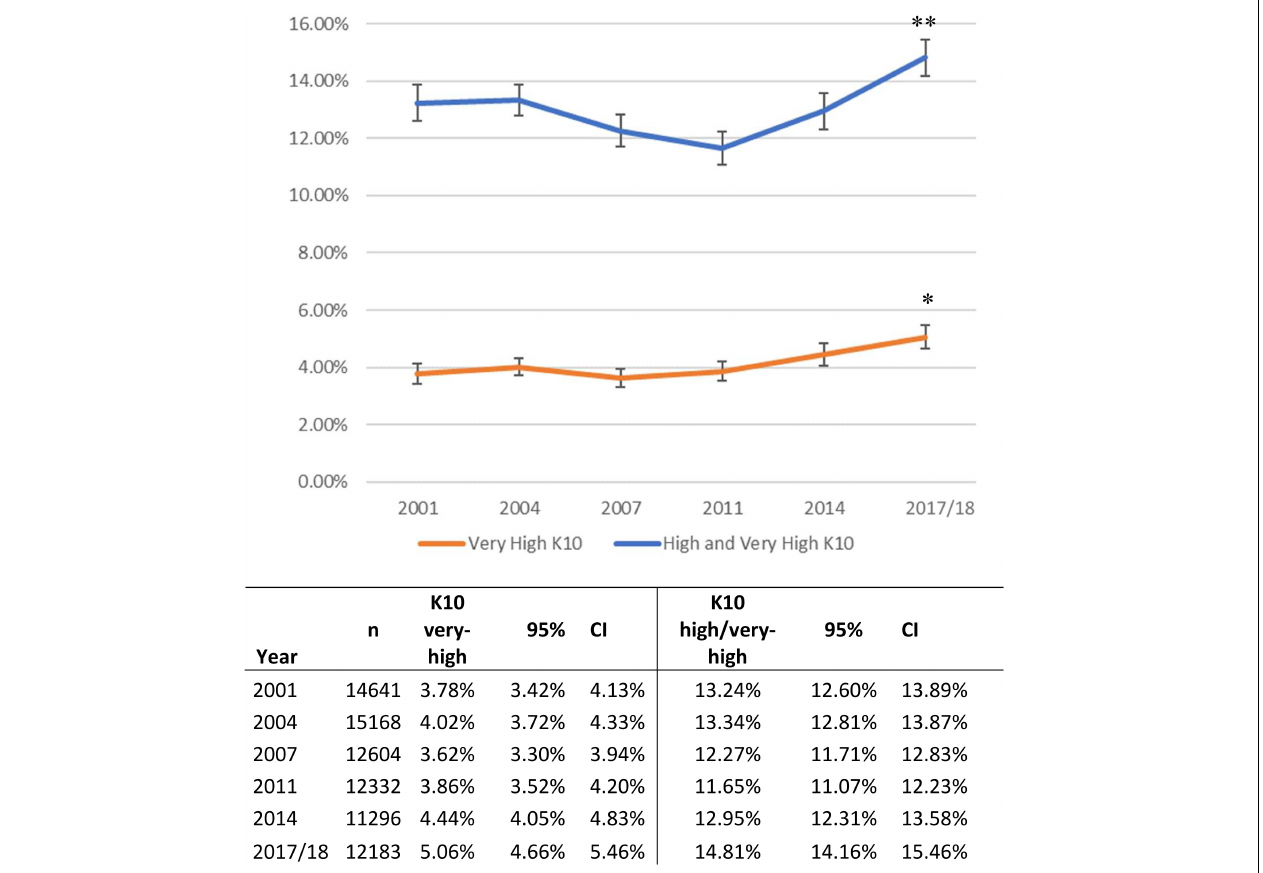
FIGURE 1 | Age-standardized prevalence of psychological distress in the Australian working age population, 2001–2017. a Standardized to 2001 Australian Census. Derived from a total of n = 78,204 survey participants aged 18–64 years. ∗∗ Rate at 2017 significantly greater than all previous years ( p < 0.001). ∗ Rate in 2017 significantly greater than 2001, 2004, 2007, and 2011 ( p <